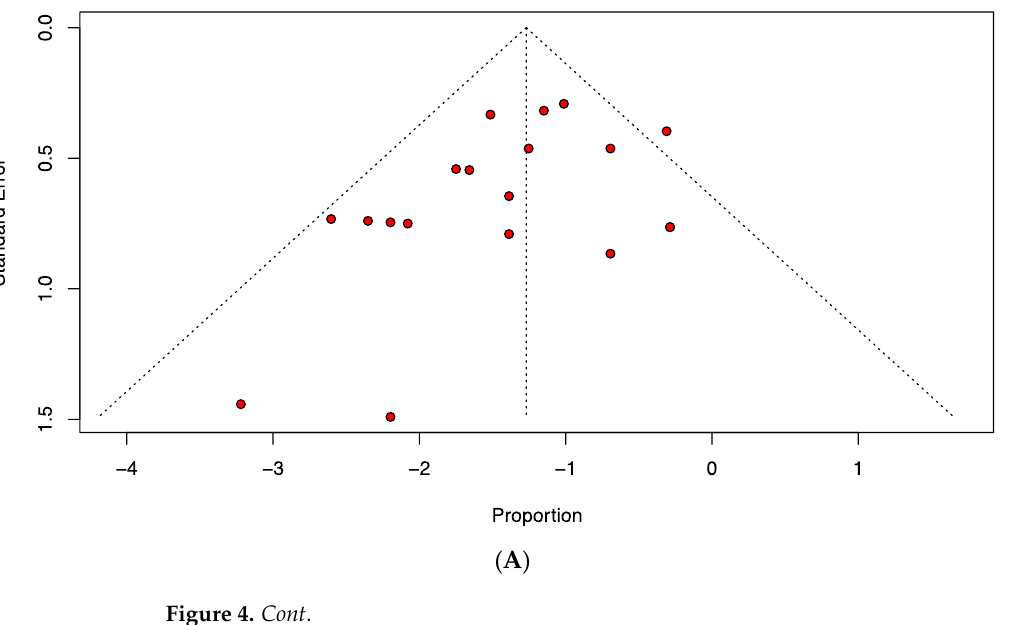
Table 5. Rates of AVN according to severity in open reduction.